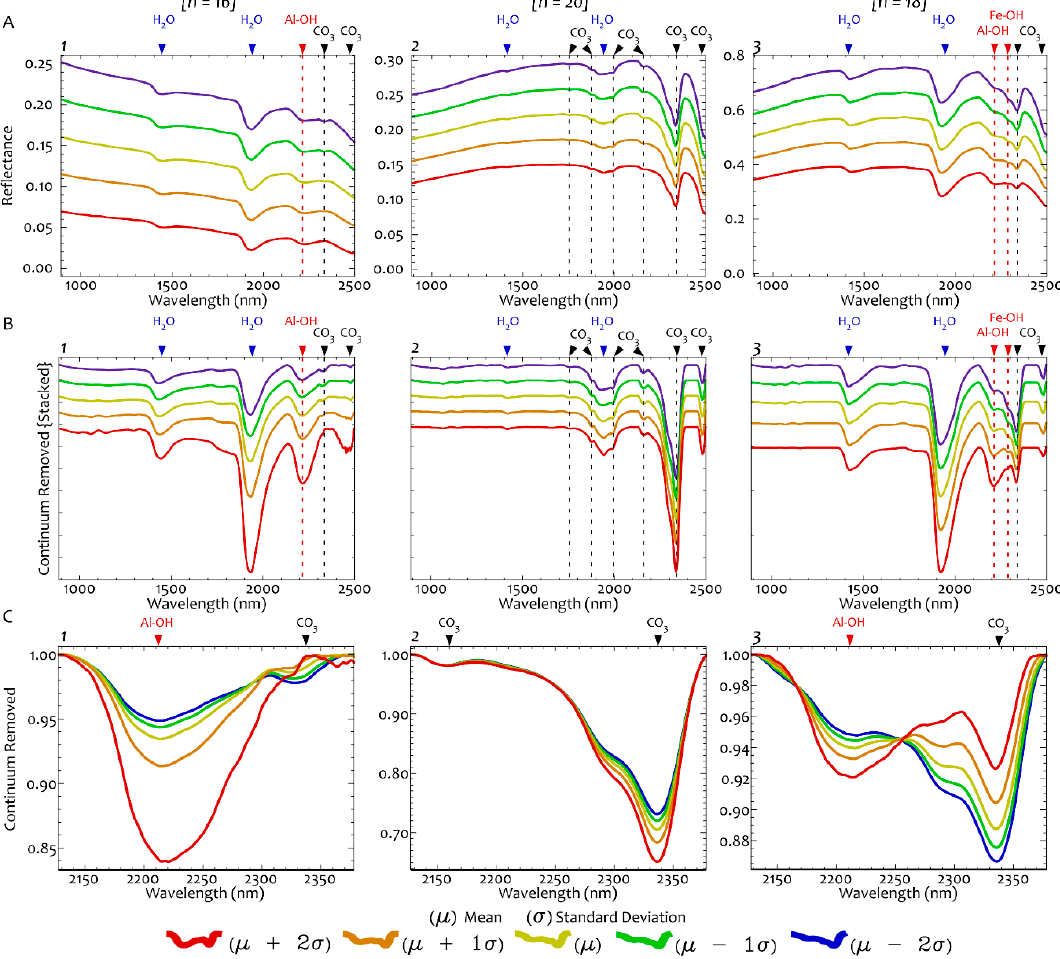
Figure 8. ( A ) Representative reflectance spectra of chert ( A1 ), limestone ( A2 ), and tripolite ( A3 ) calculated using standard deviation ( σ ) around the mean (µ). ( B ) Continuum removed spectra of chert ( B1 ), limestone ( B2 ), and tripolite ( B3 ). The spectra are offset by 0.1 for clarity. ( C ) Spectra of chert ( C1 ), limestone ( C2 ), and tripolite ( C3 ) with continuum removed over 2128–2378 nm range. The number of samples analyzed is indicated by [n].